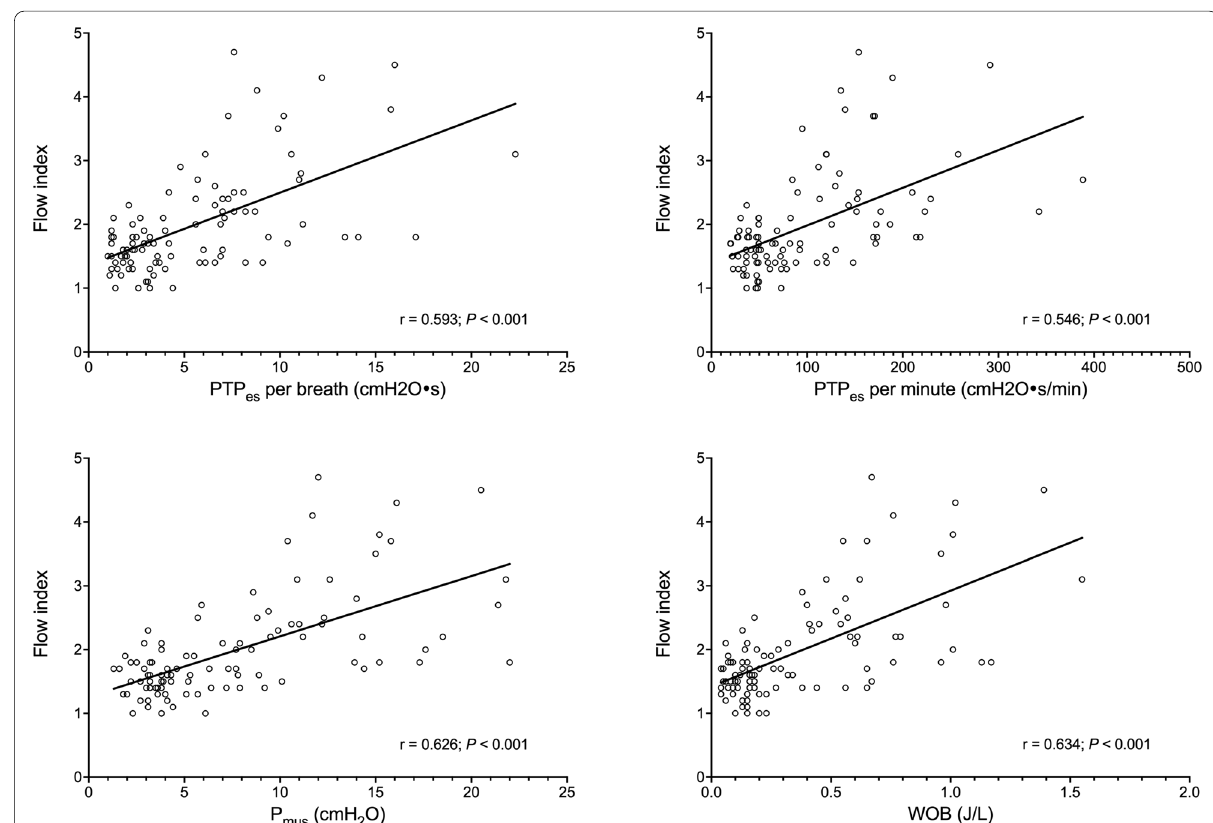
Fig. 2 Correlation of flow index with inspiratory effort parameters derived from esophageal pressure. The flow index correlated significantly with the esophageal pressure–time product (PTP